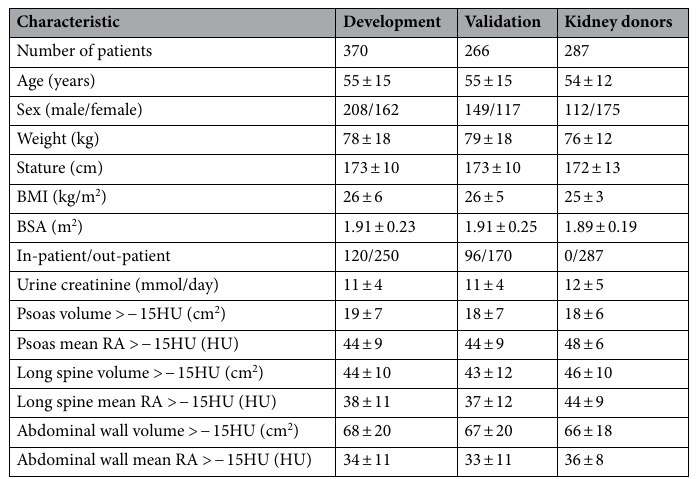
Table 1. Patient characteristics in the development, validation, and kidney donor data sets. Values are expressed as mean ± SD. BMI body mass index, BSA body surface area, RA radiation attenuation, HU hounsfield units.